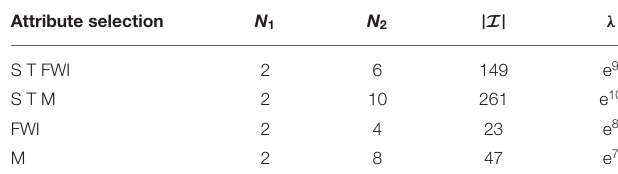
TABLE 4 | Optimal parameter choices for the experiments from Table 3 .